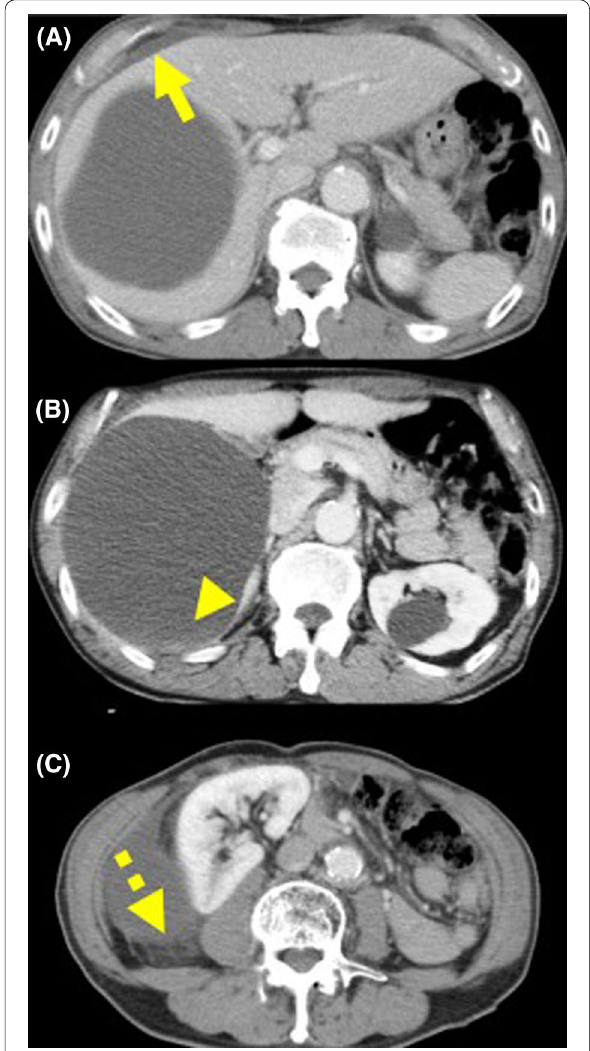
Fig. 1 Enhanced CT of case 1. A CT demonstrated a simple hepatic cyst occupying the right lobe of the liver, and fluid collection on the surface of the liver (arrow). B The Hounsfield Unit level was 40 at the lower level of the cyst (arrowhead). C A part of the cystic wall was not smooth but serrated (dotted